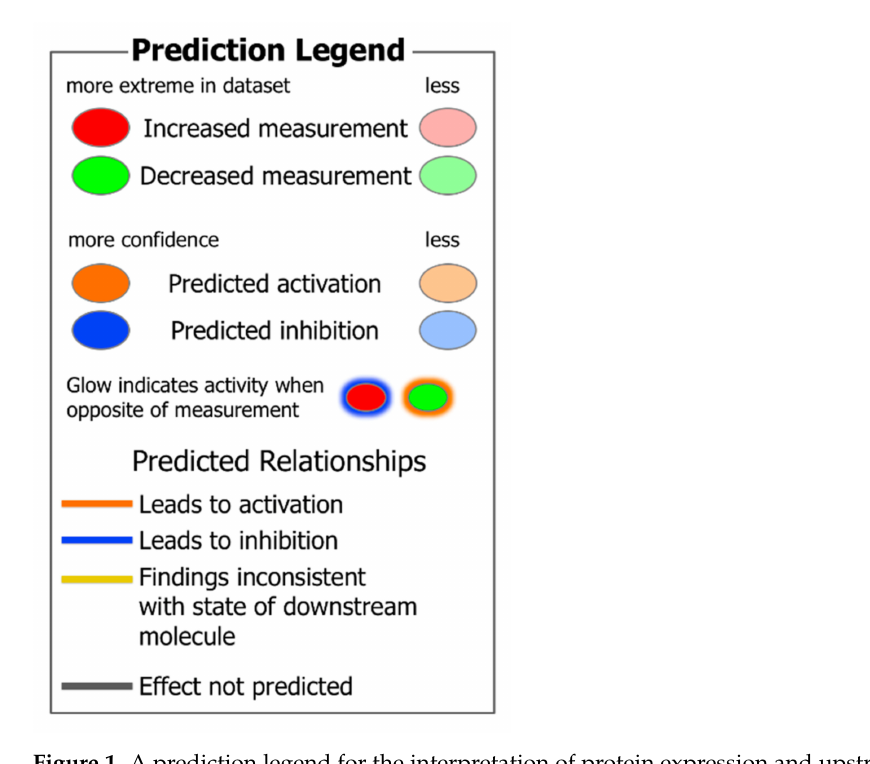
Figure 1. A prediction legend for the interpretation of protein expression and upstream regulator and function analysis in tables and